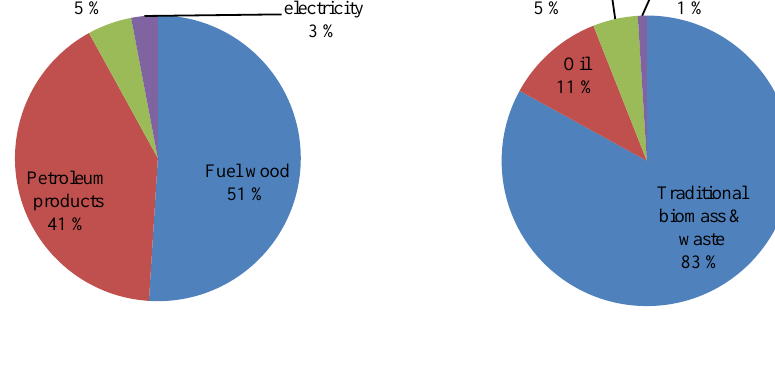
Fig. 9. The Nigeria energy mix. [20] Fig. 10. Primary energy consumption and utilization of Nigeria. [22]